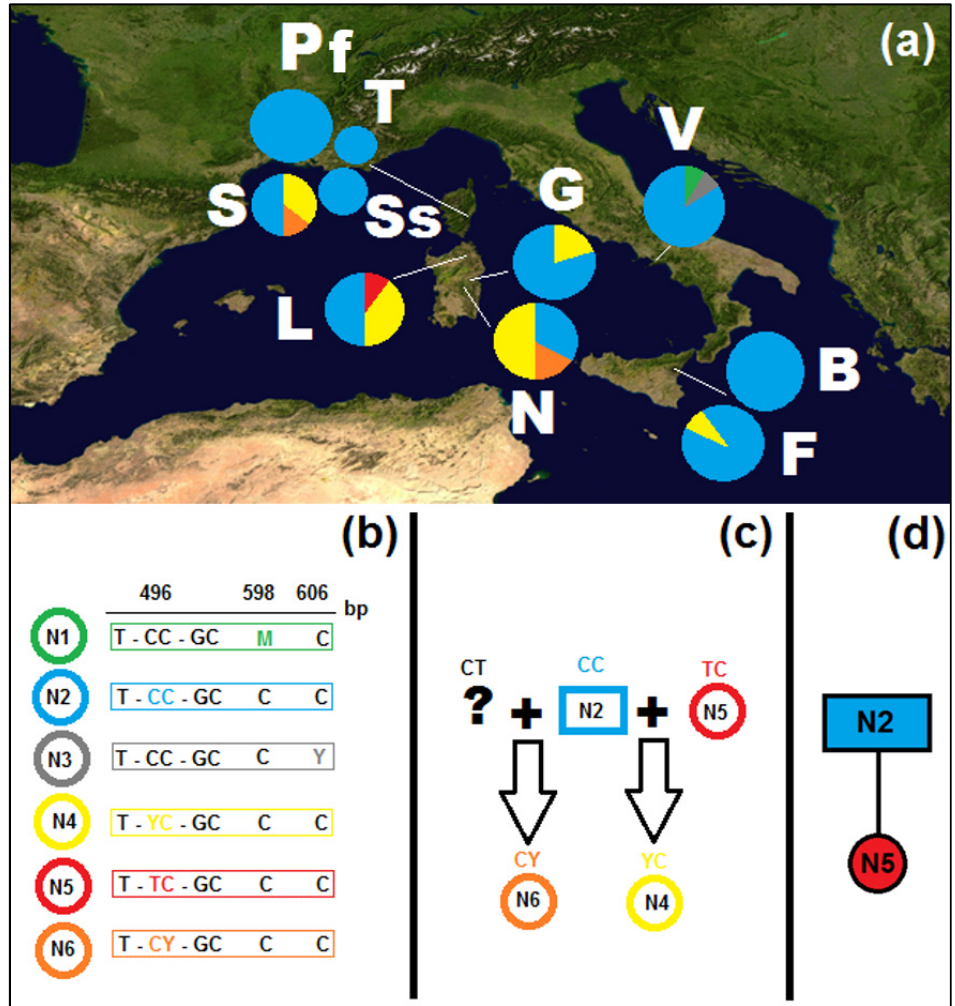
Figure 2. ( a ) Distribution map of the populations of Genista etnensis and relative frequency of the ITS genotypes (nrDNA) (populations labels: B = Mount Baracca, F = Fornazzo, G = Genna Silana, L = Mount Limbara, N = Villagrande Strisaili, Pf = Serra Fiumorbu, S = Solenzara, Ss = road between Sari and Solenzara, T = Solaro, V = Mount Vesuvius); ( b ) genotype and relative SNPs (see Supplemental File S2 for the alignment, GenBank accessions N1–N6: OP794491–OP794496); ( c ) possible crosses between genotypes; ( d ) reconstructed genealogy of unambiguous genotypes.